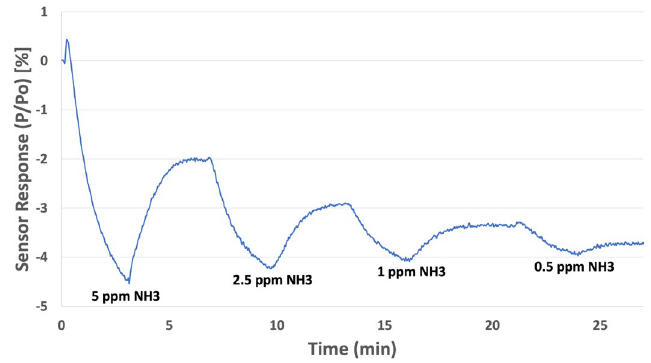
Figure 2. Response of a thermodynamic sensor employing SnO 1+ catalyst to ammonia. Concentrations ranged from 0.5 to 5